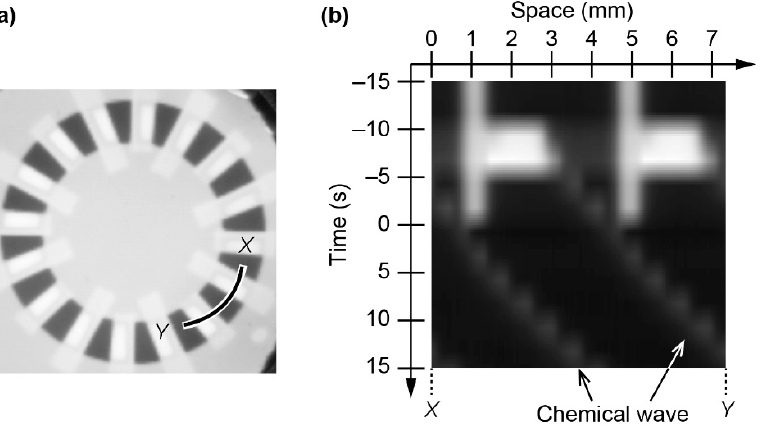
Figure 3. ( a ) Snapshot showing photoexcitation. Rapid increase in the light intensity induced exci- tation of the BZ reaction. ( b ) Space–time diagram showing the generation of unidirectional chemical waves. The data was obtained on line XY, as indicated in ( a ). The white regions indicate strong illumination, corresponding to narrow and wide lines.